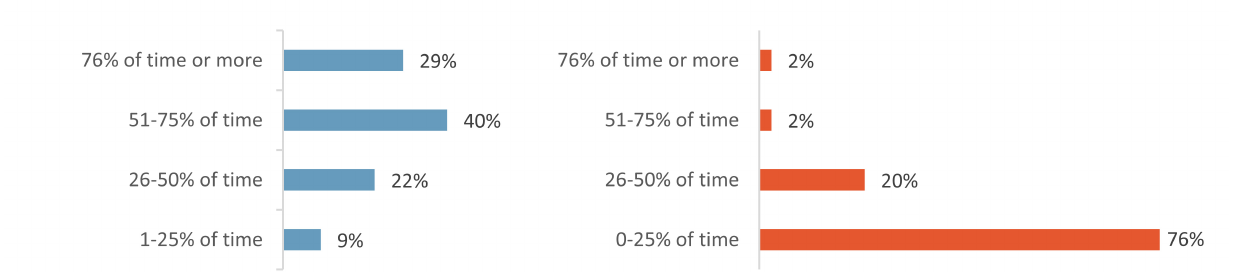
Frontiers in Education |